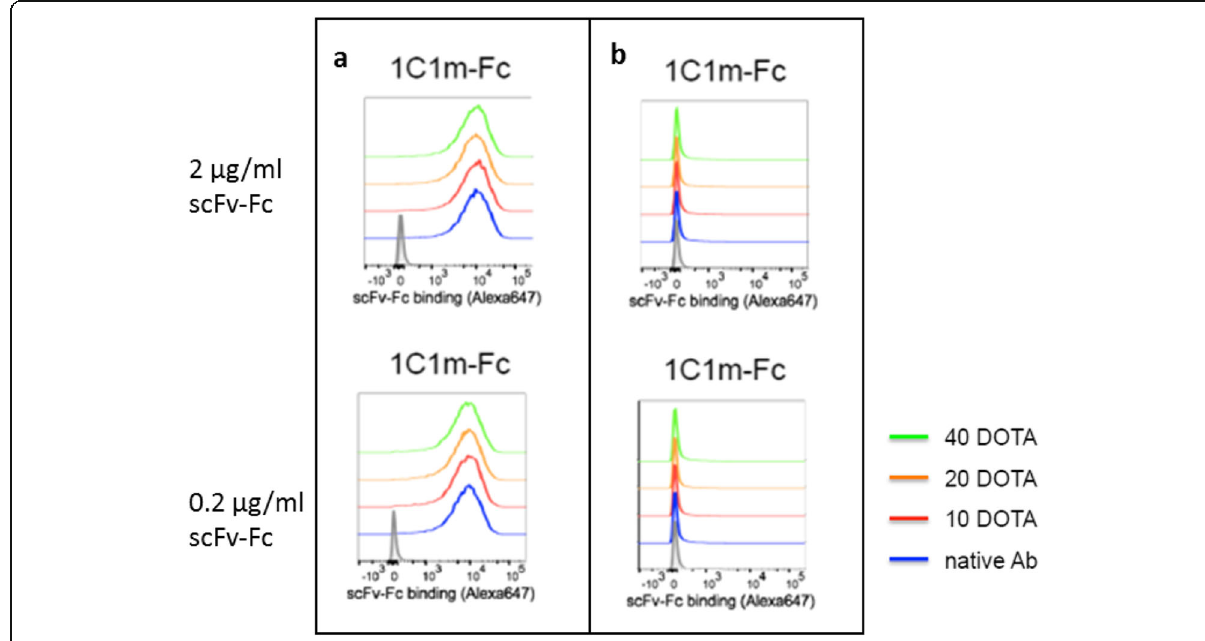
Fig. 4 Flow cytometry analysis. a Binding to huTEM-1 positive SK-N-AS cells. b Binding to huTEM-1 negative HT-1080 cells